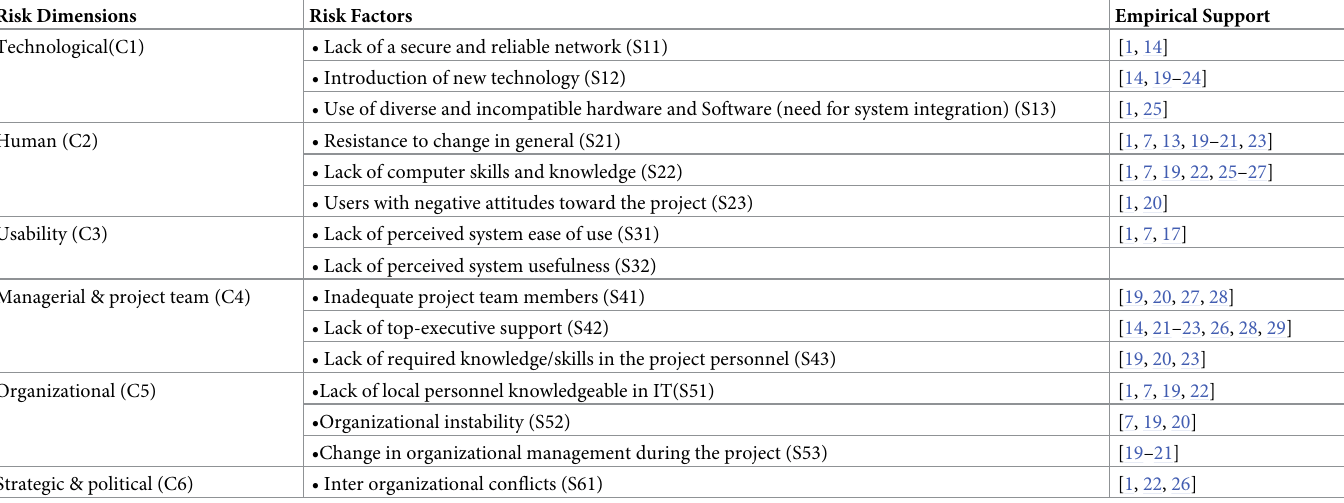
Table 1. Risk dimensions, risk factors, and empirical support. Risk